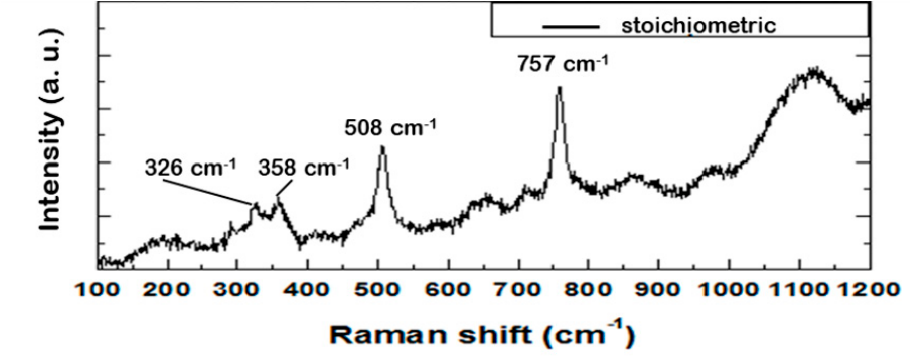
Figure 5. Raman spectra of the obtained Al-1 3S powders excited by a 633 He–Ne laser.